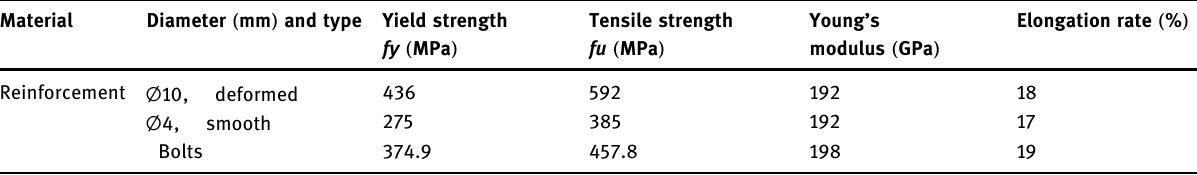
Table 3: Experimental mechanical property of steel Material